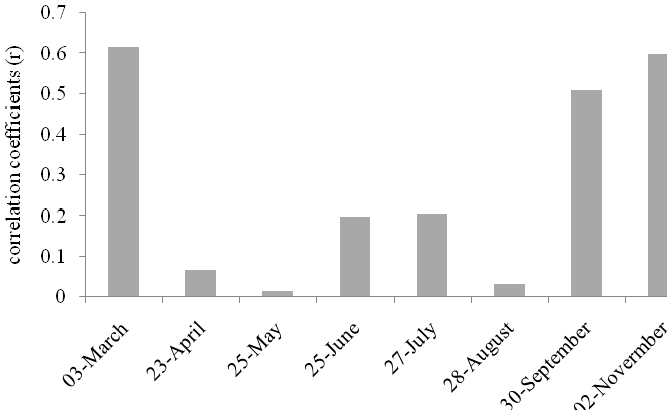
Figure 3. Correlation coefficients ( r ) between biomass and NDVI on different dates.